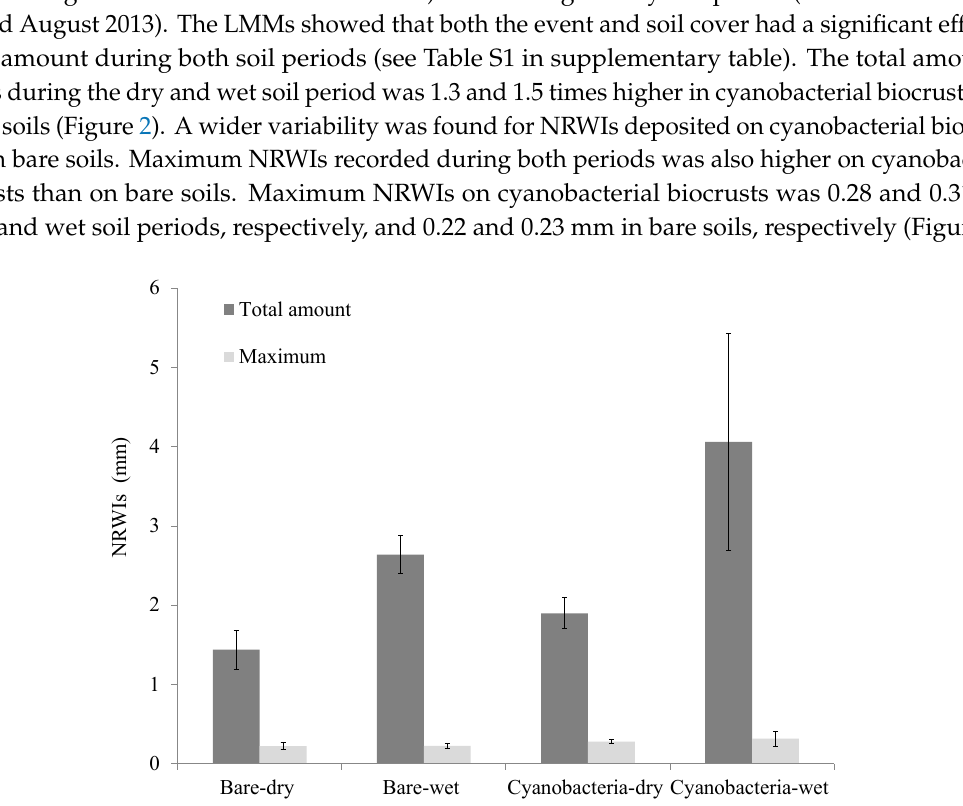
Figure 2. Total and maximum non-rainfall water inputs (NRWIs) amount in well-developed cyanobacterial biocrusts and bare soils at El Cautivo, during a dry (1 June–31 July 2013) and wet soil period (1 November–31 December